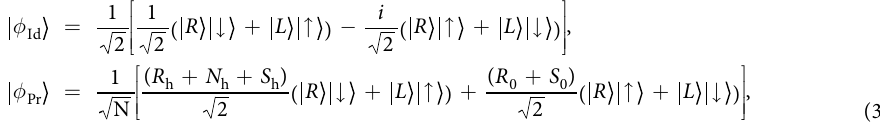
(ideal case: no noise and leakage) and φ Id